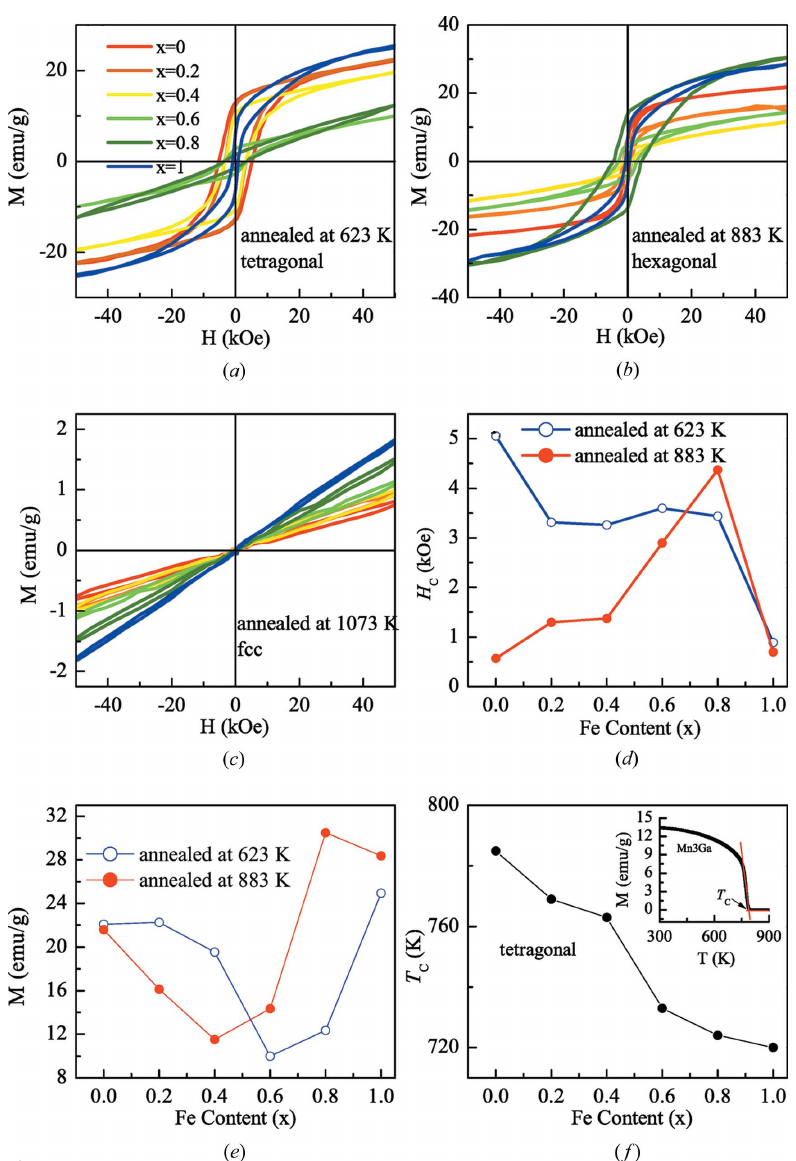
Figure 7 Magnetic hysteresis loops measured at 5 K for Mn 3 (cid:2) x Fe x Ga samples treated at ( a ) 623 K, ( b ) 883 K and ( c ) 1073 K; ( d ) the coercive field as a function of Fe content for samples treated at 623 and 883 K; ( e ) the magnetization under a field of 50 kOe at 5 K as a function of Fe content; ( f ) the Curie temperature T C as a function of Fe content for the tetragonal Mn 3 (cid:2) x Fe x Ga alloy, and the inset shows the M–T curves of Mn 3 Ga, showing the tangent method for determining T C